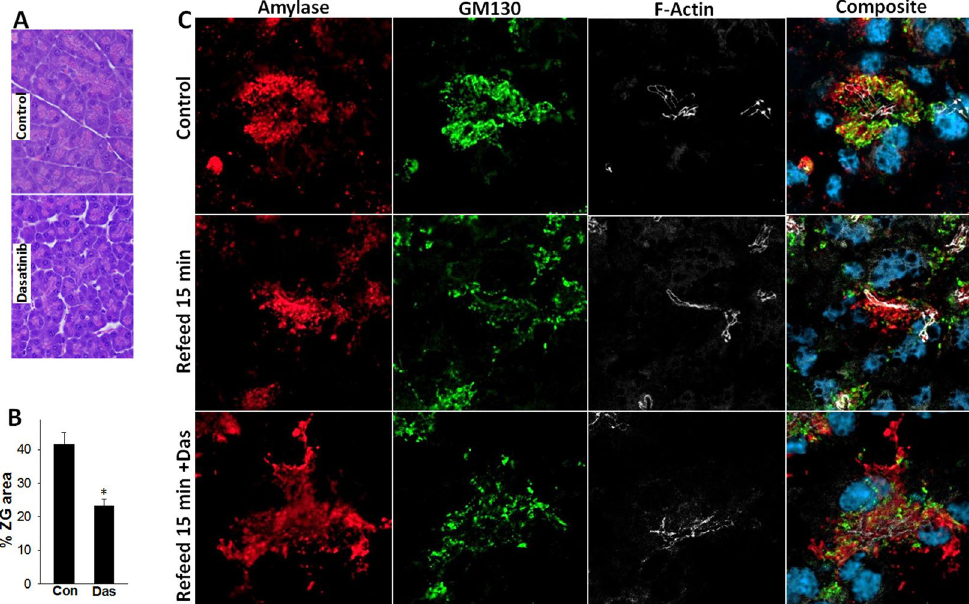
Figure 5. Effect of Pharmacologic inhibition of Src in vivo on pancreatic acinar zymogen granule area and amylase staining. ( A ) Bright field imaging of histological sections of C57BL/6 mouse stained with hematoxylin and eosin with no treatment (control) and treatment with Dasatinib. Note the lesser amount of pink (zymogen granule area in with Dasatinib treatment. ( B ) Bar graph showing the % acinar cell area occupied by zymogen granules in the control and Dasatinib treated mouse pancreas. ( C ) Immuno fluorescence of amylase (red), GM130 (green), F-actin (white) and composite in normal fed mice (control; upper panel), mice fasted for 48 hours followed by 15 minutes of refeeding (middle panel) and mice treated with Dasatinib 3 hours prior to refeeding. Note, the diffuse cytoplasmic staining of amylase in the Dasatinib treated